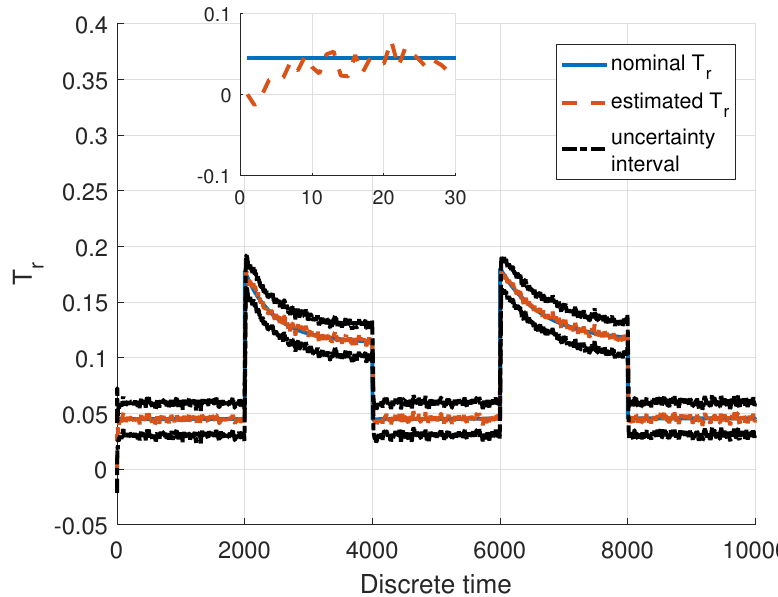
Figure 8. Nominal and estimated T r .